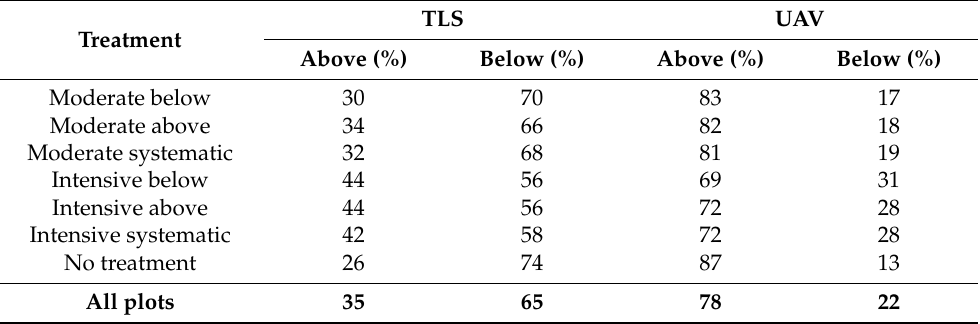
Table 9. Percentages of terrestrial laser scanning (TLS) and unmanned aerial vehicle (UAV) measured points above and below the midpoint of the z -axis (i.e., the height of trees). TLS UAV Treatment Above (%) Below (%) Above (%) Below (%) Moderate